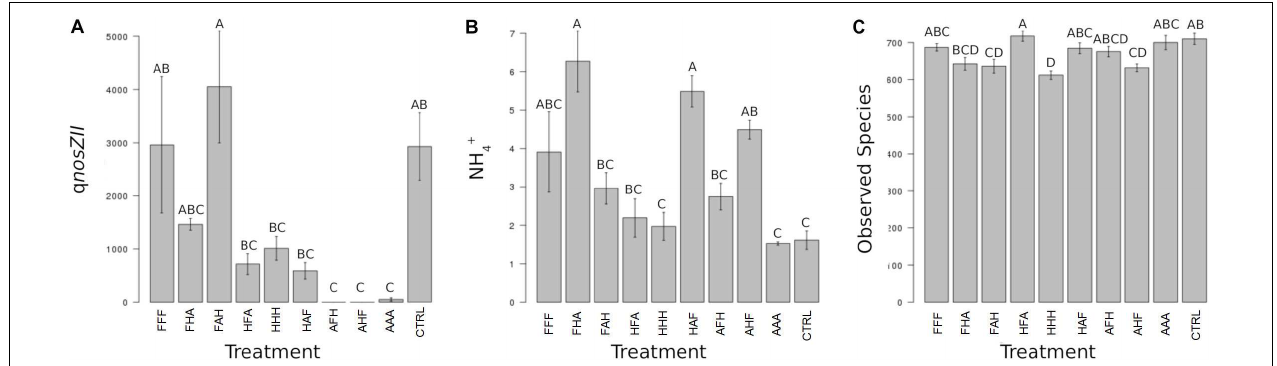
FIGURE 4 | Ecosystem properties significantly impacted by the chronology of compounded disturbance at T 4 . Different letters above the bars indicate significant differences according to Tukey’s test ( p < 0.05). (A) qnosZII corresponds to the abundance of bacteria harboring the nosZ clade II N 2 O reductase gene and is expressed in gene copies x g − 1 DNA. (B) NH 4 + corresponds to soil NH 4 + pool sizes and is expressed in mg N x kg − 1 DNA. (C) Observed Species corresponds to the species richness observed in treated and control microcosms and is expressed in number of species.